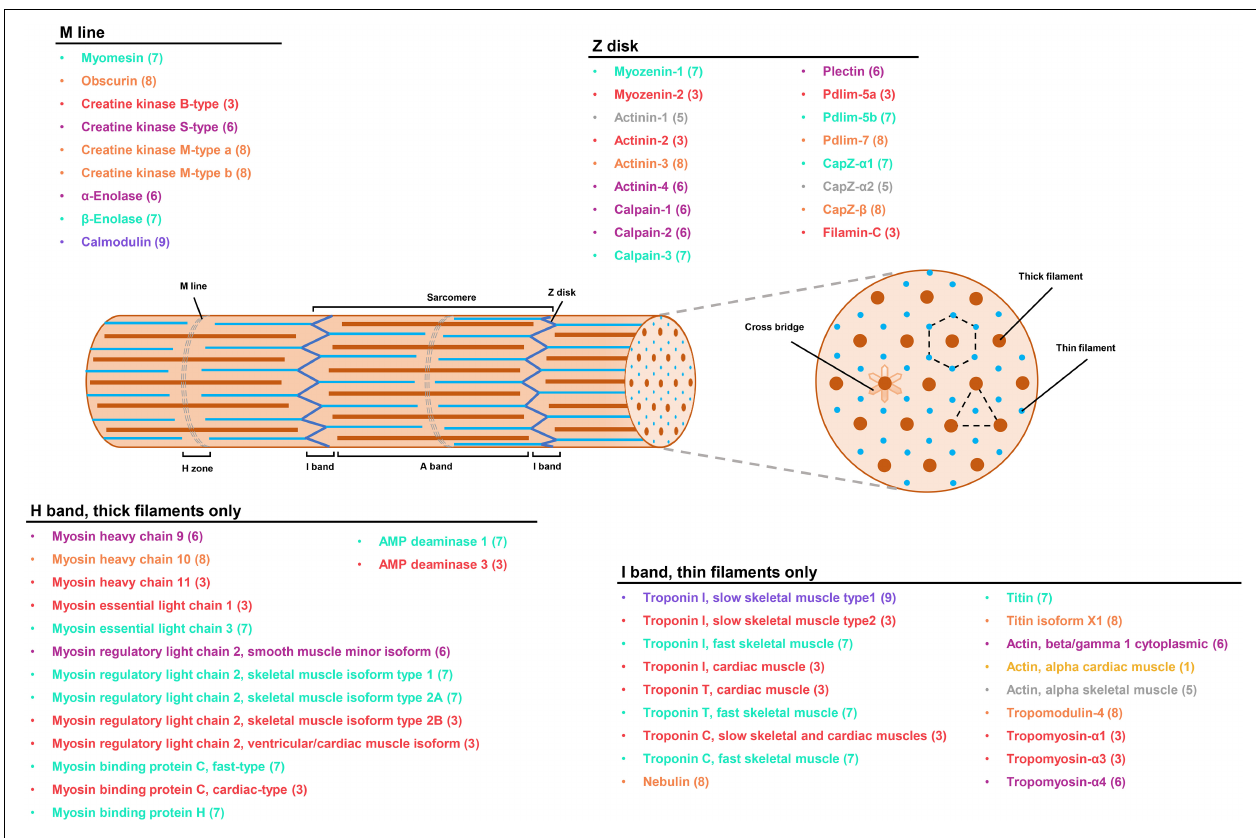
FIGURE 6 | The expression profiles of myofibrillar proteins in P. dentex skeletal muscle by integrative transcriptome and proteome. Localization of myofibrillar proteins mapped onto the schematic of the sarcomere was predicted based on the published vertebrate counterparts (Estévez et al., 2012; Holland and Ohlendieck, 2013; Ochiai and Ozawa, 2020). The colors of fonts and numbers in parentheses represented gene expression information, corresponding to the quadrants distribution in Figure 5C .